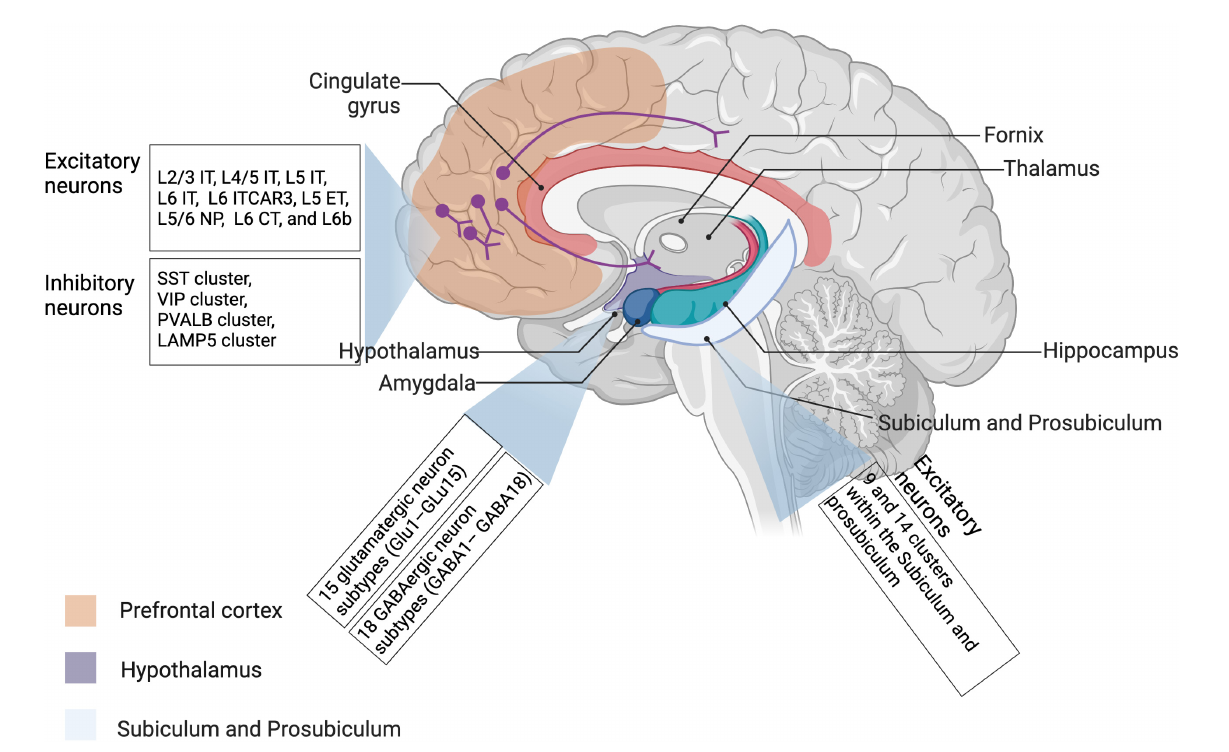
Table 2 . IT, intratelencephalic-projecting neurons; ET, extratelencephalic-projecting neurons; NP, near-projecting neurons; CT, corticothalamic projecting